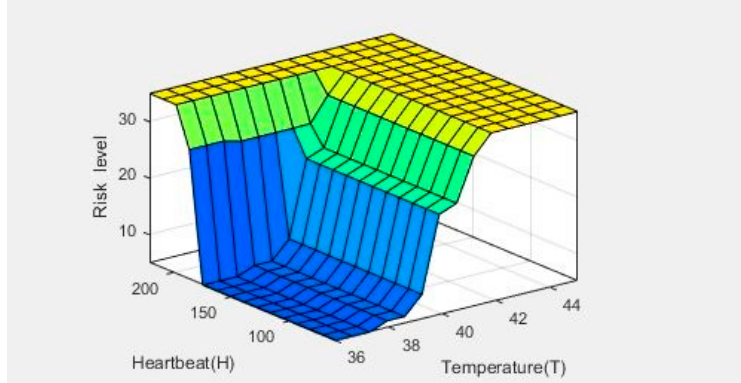
Figure 14. Three-dimensional relationship map between heart rate, temperature, and heat stroke risk level.